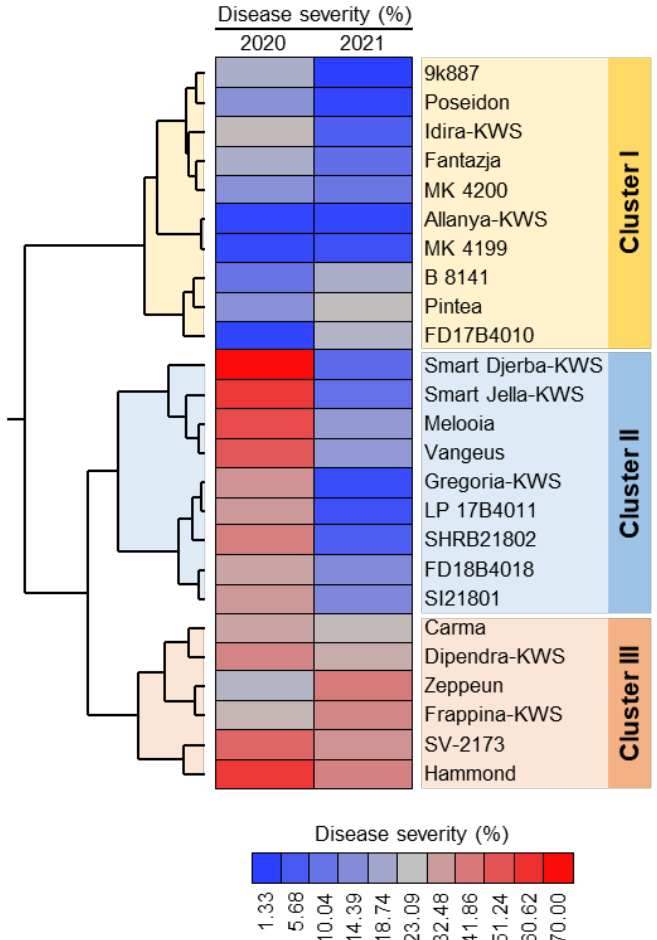
Figure 1. Two-way hierarchical cluster analysis (HCA) of the reaction of 25 sugar beet cultivars to powdery mildew disease caused by Erysiphe betae under greenhouse conditions during the 2020 and 2021 seasons. The data presented are the means of three biological replicates ( n = 3). Rows represent different cultivars, whereas columns represent disease severity (%). Heatmap was colored based on the disease severity percentages where the red color represents a higher disease severity (%) and the blue color represents a lower disease severity (%). See the scale at the bottom of the heatmap. The experiment was repeated twice with similar results.